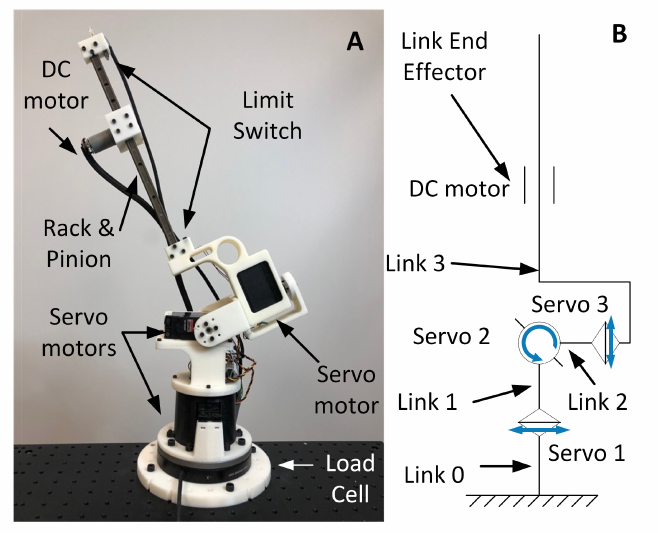
Figure 1. ( A ) The prototype of the robotic tail design. ( B ) Link assignments and details of the robotic tail mechanical